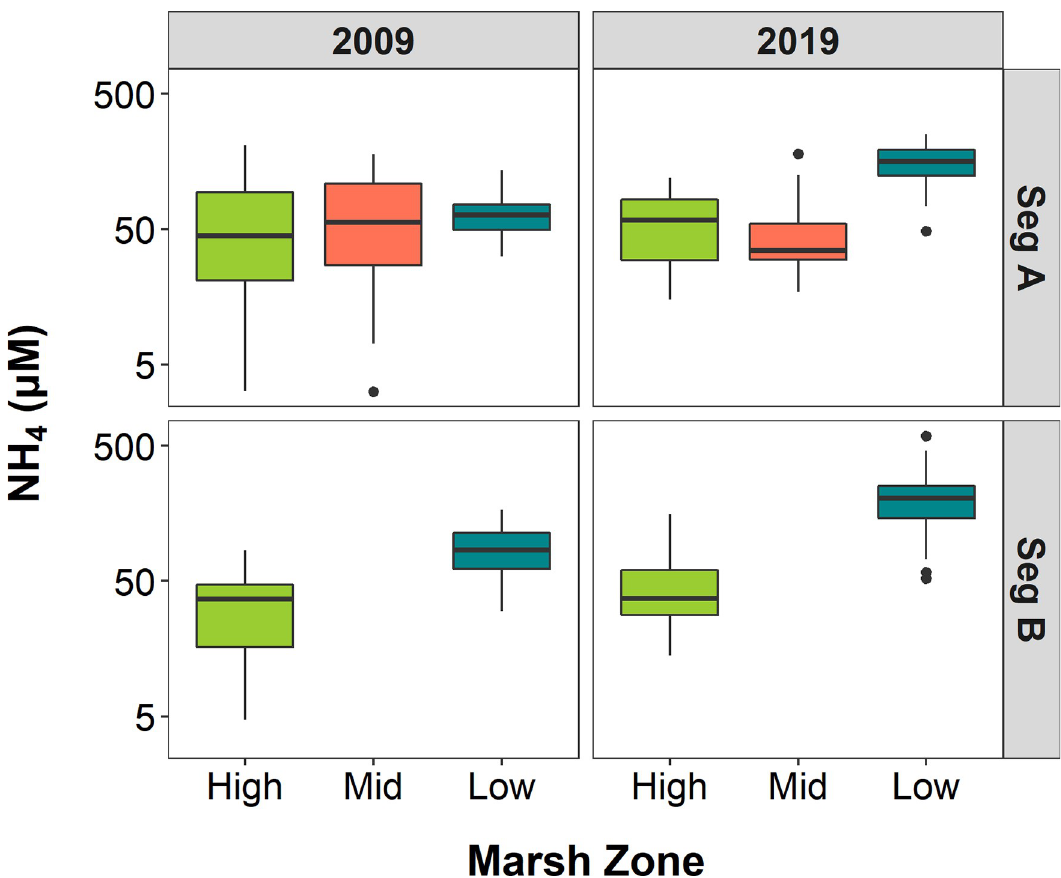
Fig 4. NH 4 concentrations by marsh zone. Box and whisker plots of porewater NH 4 concentrations across marsh zones in Segments A and B for years 2009 and 2019, with outliers included as points in line with whisker. The middle line of each box represents the median concentration, and the lower and upper lines the 25 th and 75 th percentiles. Whiskers extend to the most extreme data point no more than 1.5 the interquartile range. Permanent plots were grouped into high, mid or low marsh zones according to elevation and dominant vegetation